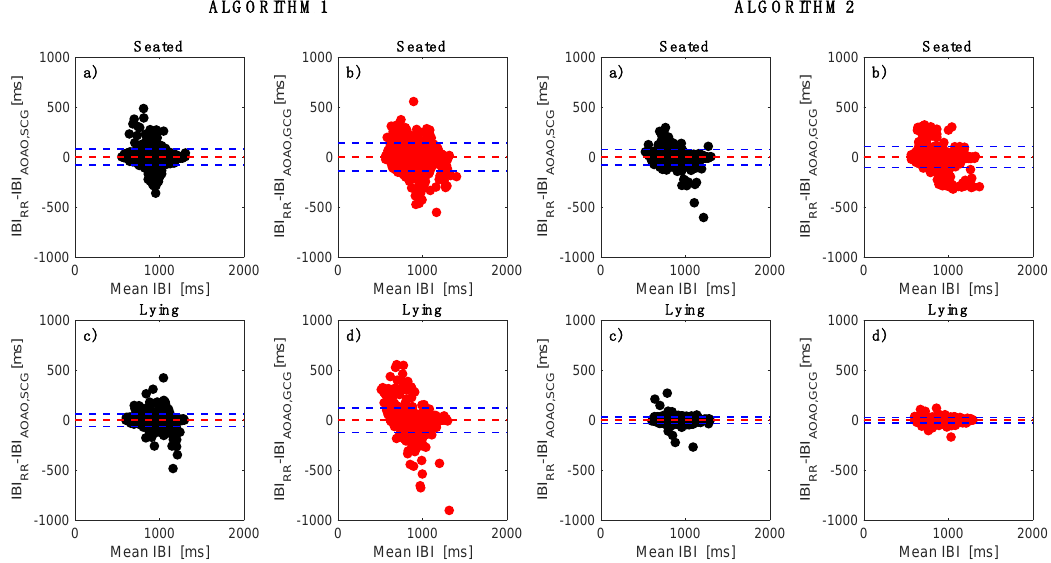
Figure 4. Bland-Altman analysis related to IBI comparison between 𝐼𝐵𝐼 𝑅𝑅,𝑖 and ( a ) 𝐼𝐵𝐼 𝐴𝑂𝐴𝑂,𝑖 estimated from SCG in seated position, ( b ) 𝐼𝐵𝐼 𝐴𝑂𝐴𝑂,𝑖 estimated from GCG in seated position, ( c ) 𝐼𝐵𝐼 𝐴𝑂𝐴𝑂,𝑖 estimated from SCG in lying position and ( d ) 𝐼𝐵𝐼 𝐴𝑂𝐴𝑂,𝑖 estimated from GCG in lying position, for algorithm 1 (panels on the left) and algorithm 2 (panels on the right). Table 1. IBI analysis: R coefficients, MOD and LOAs values.